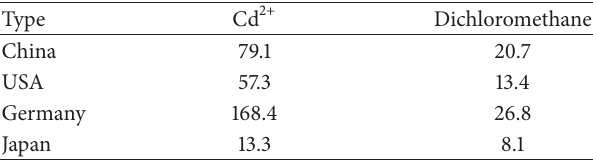
Table 4: Critical times of the